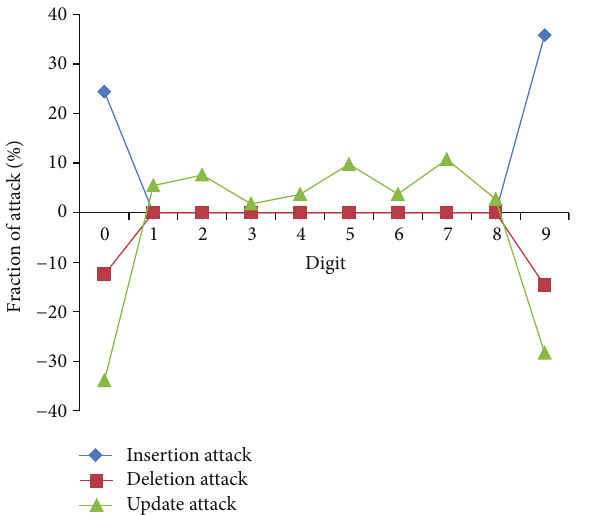
Figure 5: Characterization of malicious insertion, deletion, and update attacks on length 3 of data